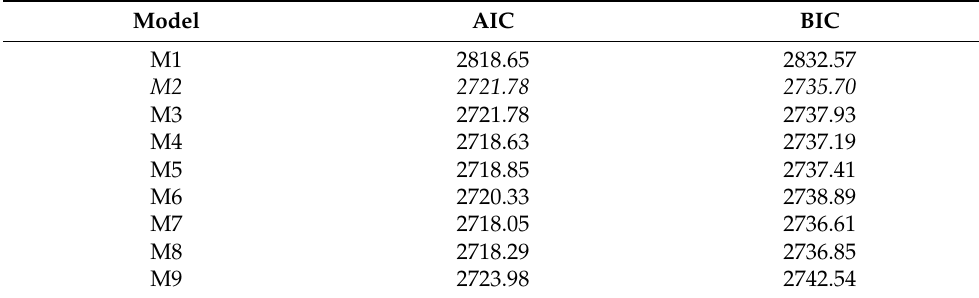
Table 5. AIC (Akaike information criterion) score and BIC (Bayesian Information Criterion) score of the base models (Table 4).